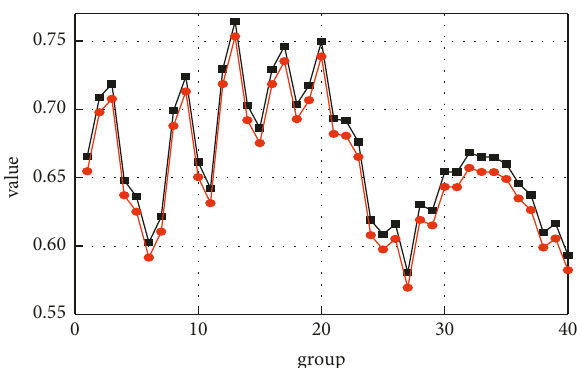
Figure 3: The predicted value of historical information features of